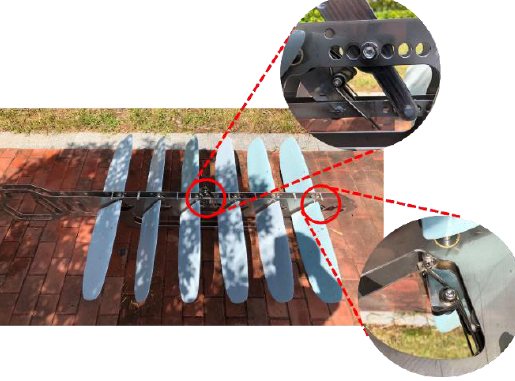
Figure 19. The physical prototype of the SALL submerged glider.